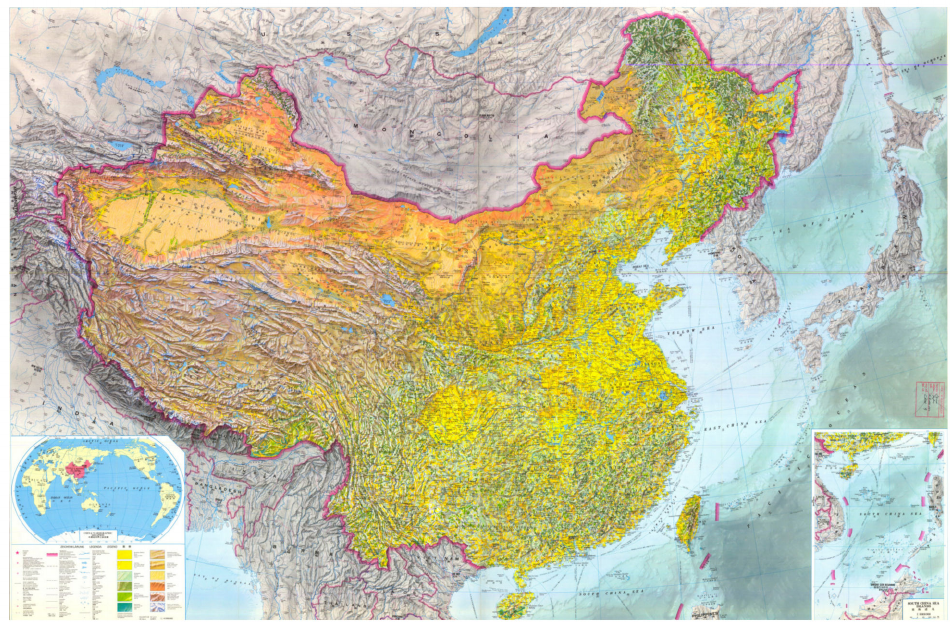
Figure 1. Topographic map of China (accessed from OnTheWorldMap.com on 10 September